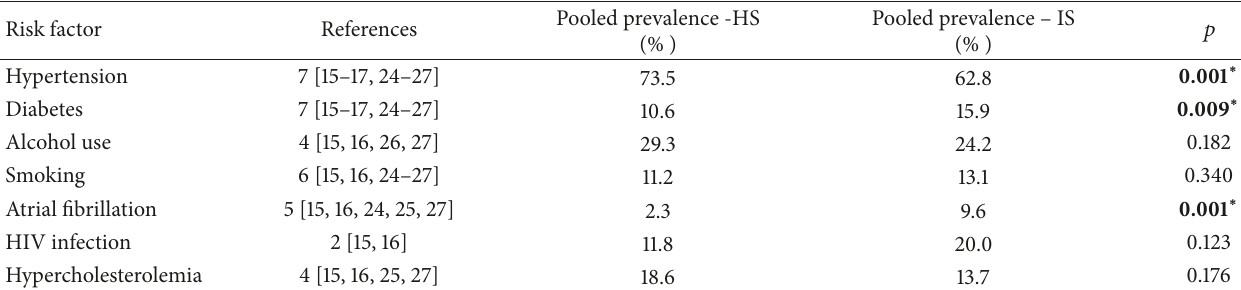
Table 4: Pooled prevalences for hemorrhagic and ischemic stroke by selected risk factors for